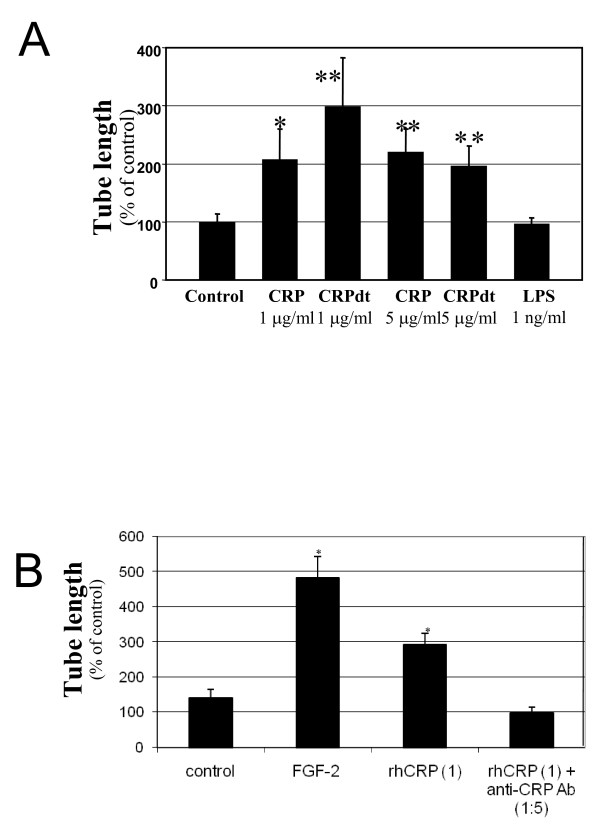
CRP induced tube-like structure formation in BAEC. A, Bar graph showing tube length as a percentage of control. Experiments were performed at least twice by triplicate. B, Bar graphs showing tube length as a percentage of control from cells treated with FGF-2 (25 ng/ml), 1 μg/ml of detoxified CRP [CRPdt] or CRP + blocking antibody against CRP for 24 h. * and ** indicate a statistically significant difference compared with the control cells (p > 0.05 and 0.001 respectively.